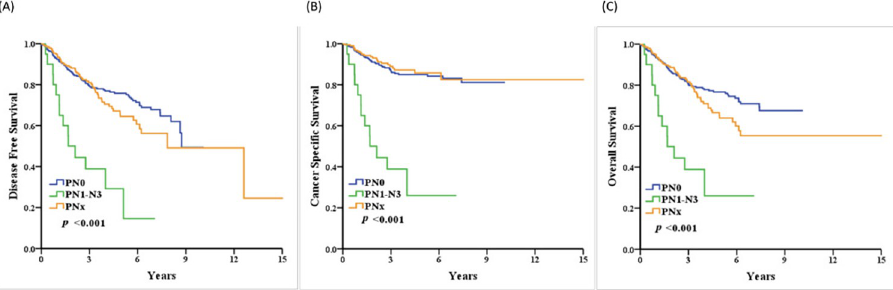
Fig 1. Kaplan-Meier curves of DFS (A), CSS (B) and OS (C) for 520 patients with pathologically proved lymph node status (pN1-3 and pN0) or without lymph node dissection (pNx)in clinical node-negative upper urinary tract urothelial carcinoma undergoing radical